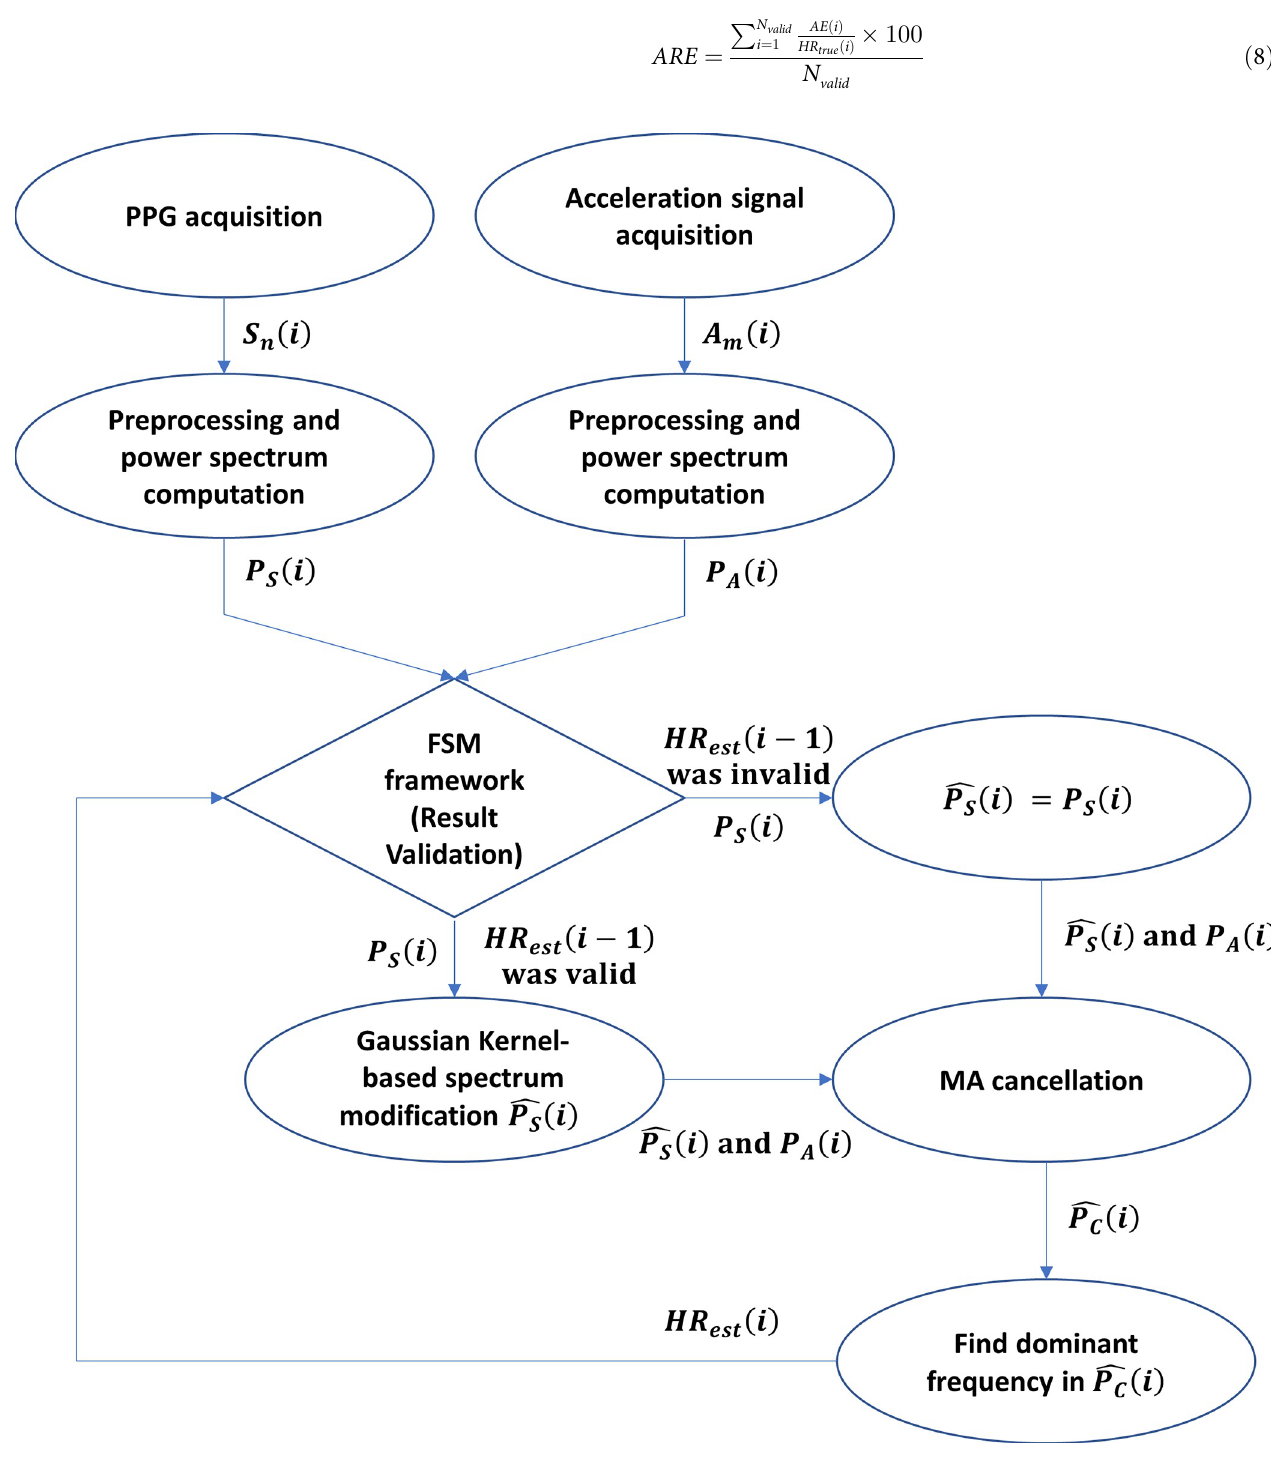
Fig 5. Flowchart of the proposed algorithm.